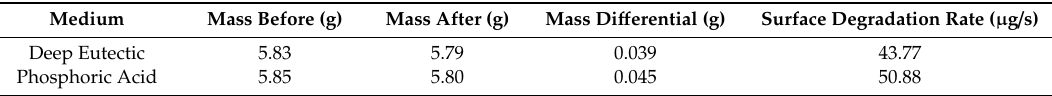
Figure 1. Schematic conceptualization of anodic leveling of aluminum surfaces via atomic force microscopy (AFM) at different phases of the study: ( A ) before electropolishing, and ( B ) after electropolishing treatments with the ionic liquid, with representative 2D surface profiles depicted ( C ) before, ( D ) during, and ( E ) after experiments. Table 1. Average electropolishing rate ( µ g / s) calculations for each electrolyte for each metal sample over a 900 s